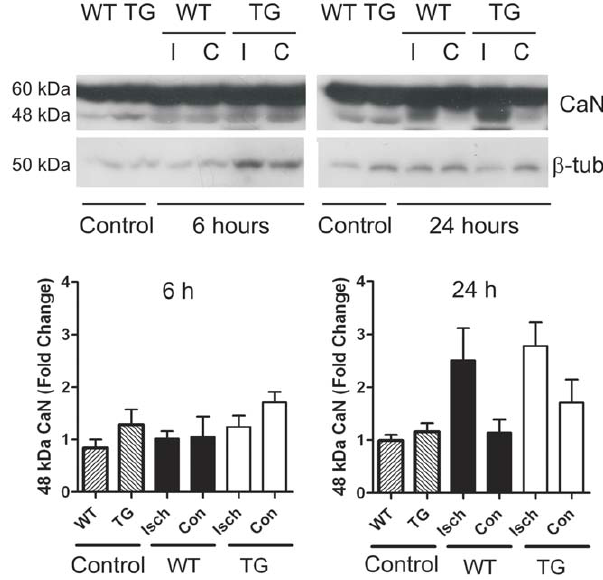
Figure 3. Over-expression of DSCR1 does not alter calcineurin (CaN) activity before or after stroke. Western blotting was used to determine the level of a constitutively active 48 kDa cleavage fragment of calcineurin that is produced upon calcineurin activation. Analysis of protein extracts from the ischemic (I, Isch) and contralateral (C, Con) brain hemispheres of naı¨ve control (or post-stroke mice revealed that there was no difference in calcineurin activity between WT and DSCR1- TG either before or after stroke. Calcineurin activity was determined by normalizing the intensity of the 48 kDa band to b -tubulin. The data are presented as mean 6 SEM (n=3 per group).